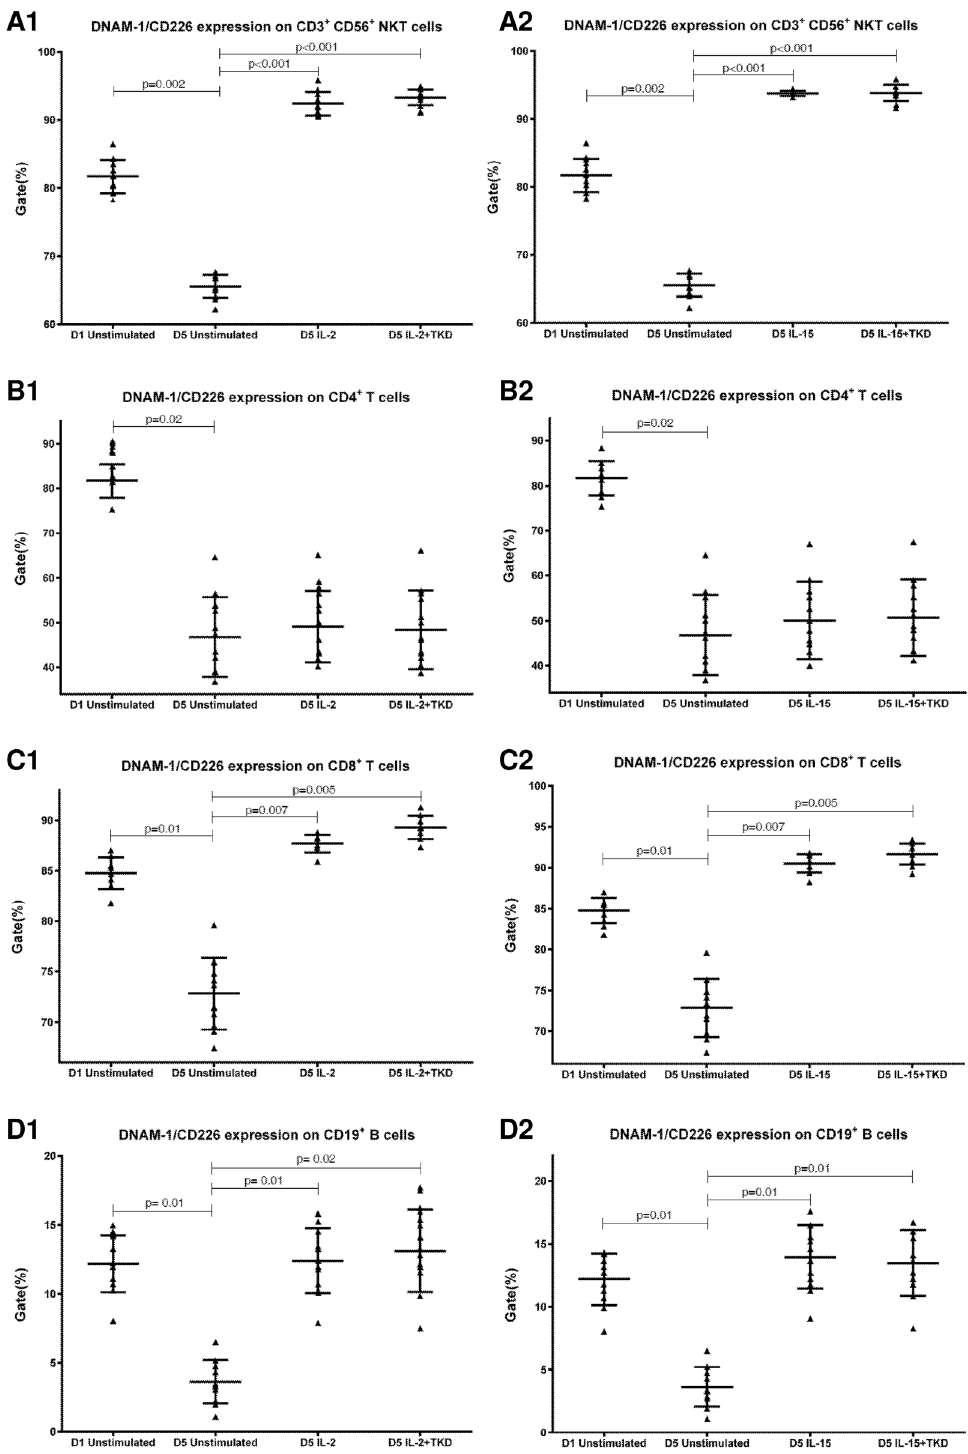
Fig 3. The effect of IL-2, IL-15, IL-2/TKD and IL-15/TKD on the expression of DNAM-1 receptor in peripheral blood mononuclear cells of healthy individuals — the proportion of CD3 + CD56 + NKT cells, CD4 + T cells, CD8 + T cells and CD19 + B cells expressing an appropriate receptor. The expression of DNAM-1 receptor on CD3 + CD56 + NKT cells, CD4 + T cells, CD8 + T cells and CD19 + B cells was examined within the fraction of unstimulated and stimulated mononuclear cells derived from 10 healthy individuals. Data are presented as means ± standard error. In total, the study cohort consisted of 52 Caucasian healthy